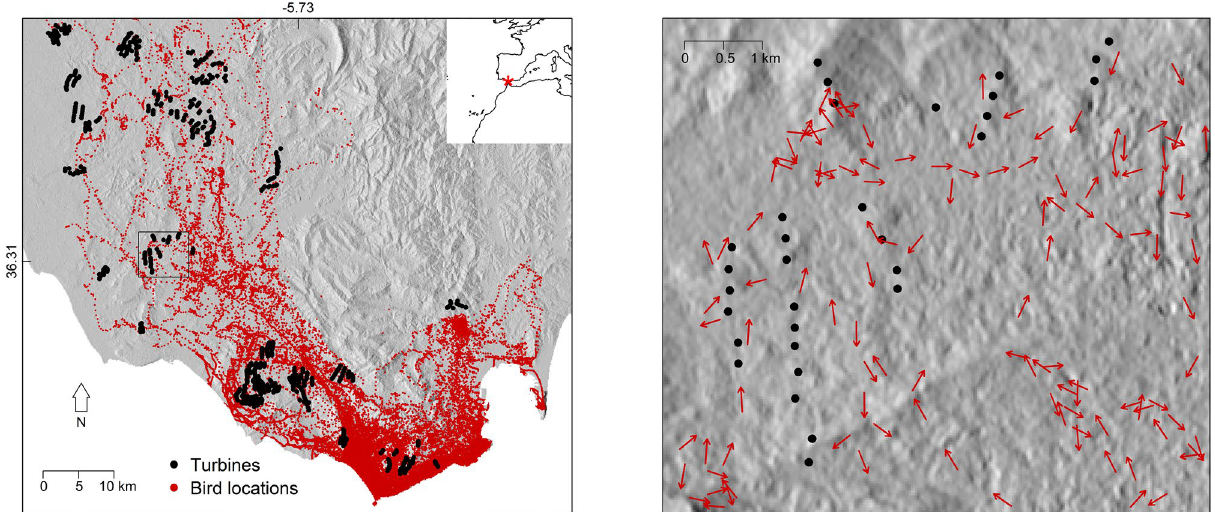
Figure 1. Left panel shows the spatial distribution of bird and turbine locations in the study area between Cadiz and Tarifa (southern Spain). Red asterisk in the top right inset marks the location of the study area. Right panel shows bird flight headings in comparison to turbine locations in a small section of the study area (square in the left panel). Hill shading was added as a background to illustrate the interaction between bird space use and topography. The data used to illustrate hill shading was retrieved from a publicly available digital elevation model (https:// lpdaac. usgs.